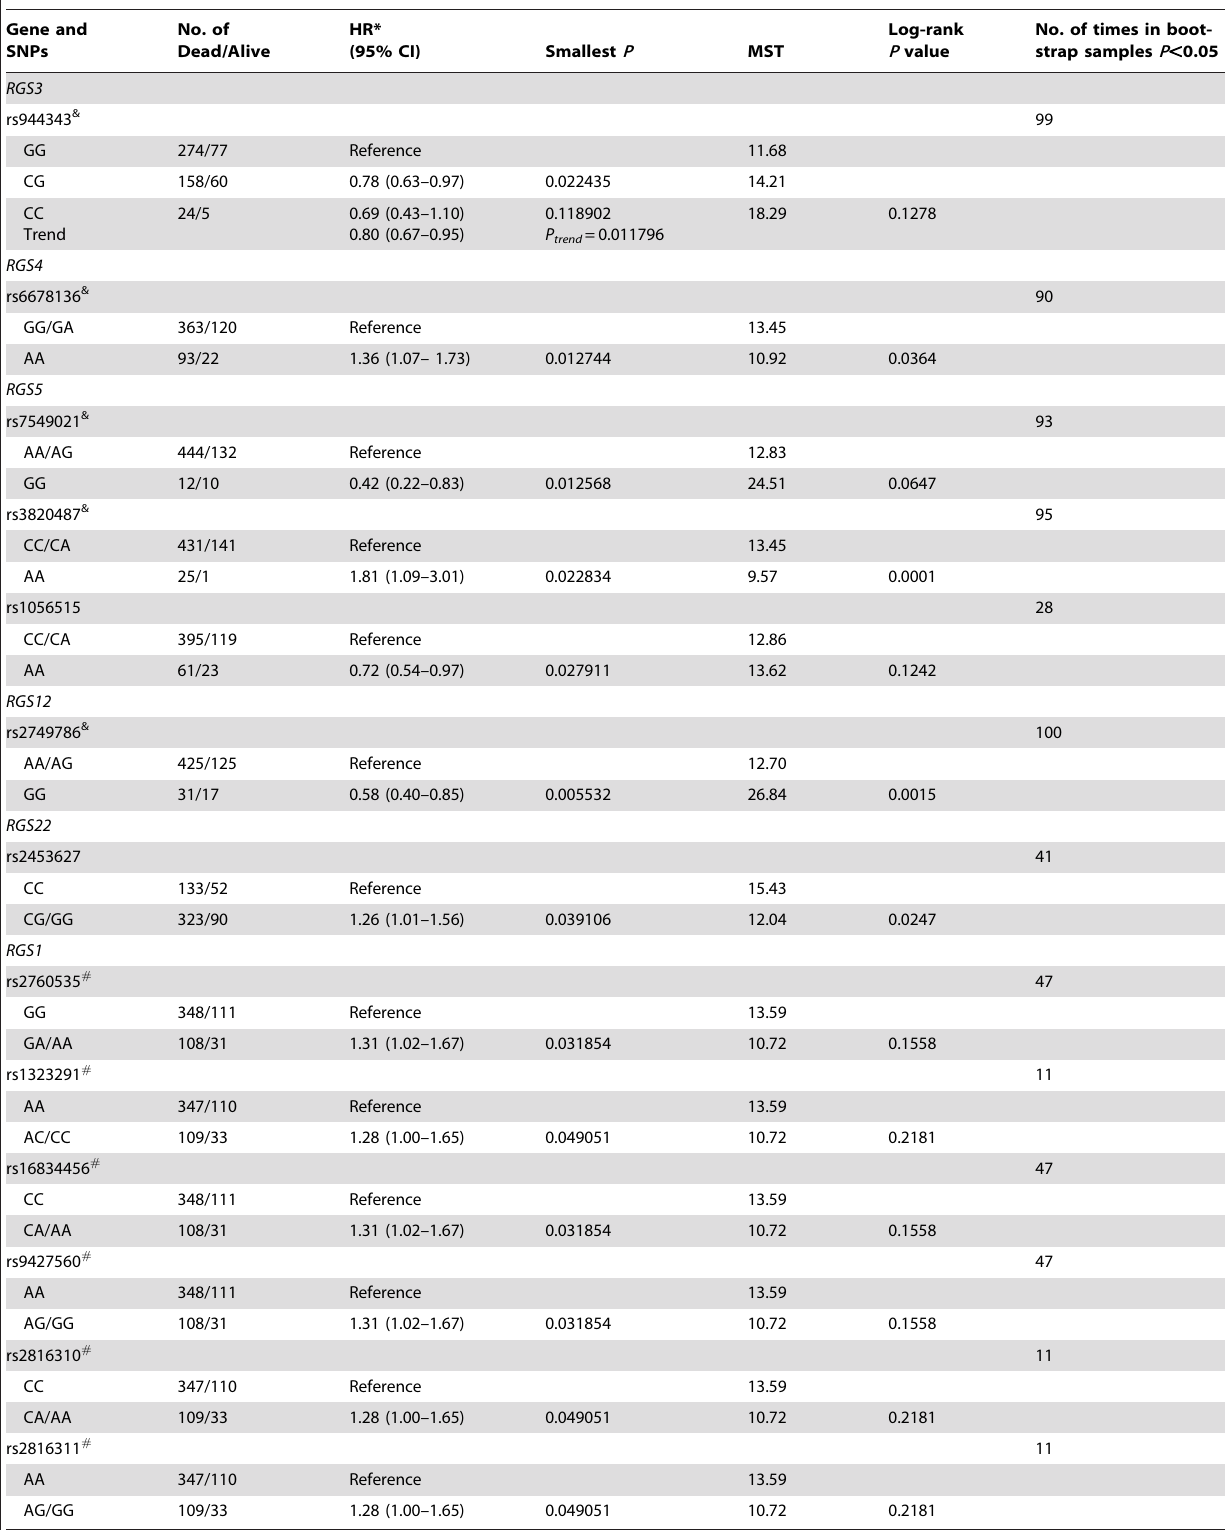
Table 2. Significant SNPs associated with overall survival.